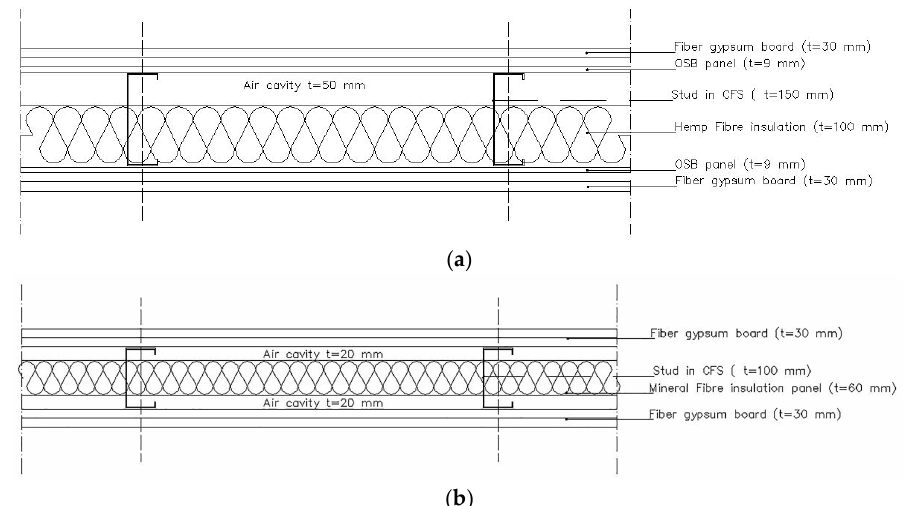
Figure 4. Internal wall sections: ( a ) load-bearing wall; ( b ) non-load-bearing wall. The roof is realized by 300 × 50 × 20 mm CFS joists, with thickness ranging between 1.50 and 3.00 mm, spaced at 600 mm. CFS tracks connected the joists at each end of the floor, and were made of 303 × 50 × 1.50 mm or 306 × 50 × 3.00 mm U sections. On the top flanges of floor joists, OSB panels are screwed and solid blocks, realized by 250 × 50 × 20 × 1.50 mm C-sections, are placed between the end joists to provide edge support to the sheathing. The floor, overall, acts as a diaphragm with joists as primary member and the OSB sheathing panels acting as bracing system.